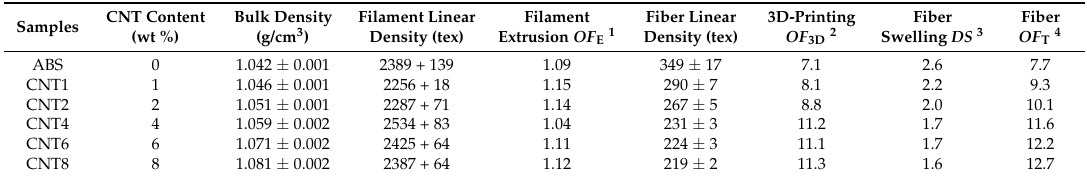
Table 3. Bulk density and linear density of ABS and ABS/CNT nanocomposite during filament extrusion and 3D fiber production. Extrusion and 3D printing draw